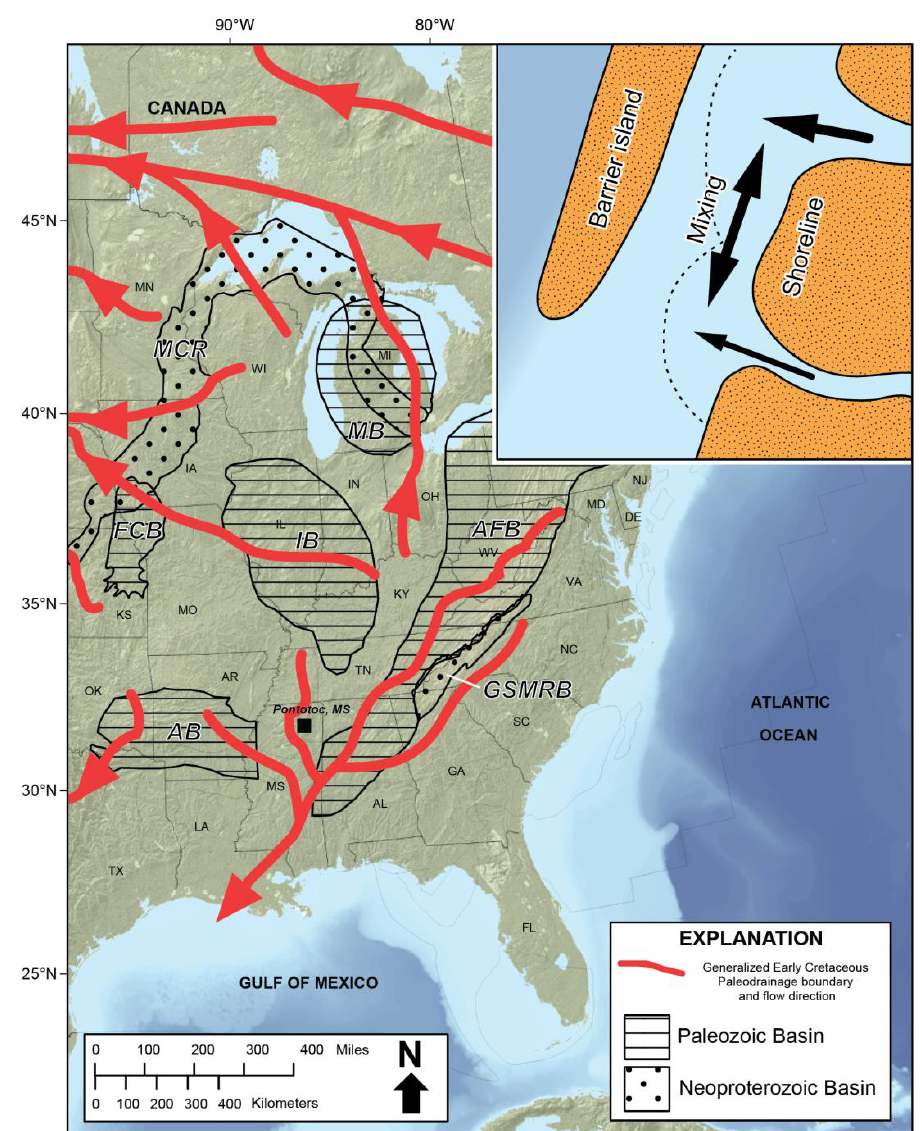
Figure 13. Map of the Paleozoic and Neoproterozoic basins of eastern North America. AB = Arkoma Basin, AFB = Appalachian Foreland Basin, FCB = Forest City Basin, GSMRB = Great Smokey Mountain Rift Basin, MB = Michigan Basin, MCR = Mid-Continent Rift. Modified from Coleman and Cahan [79]. Red lines indicate Late Cretaceous mid-continent paleodrainge and flow directions, modified from Blum and Pecha [1]. Inset: Generalized paleoenvironmental reconstruction of the region encompassing the northern and southern Pontotoc field sites (black square; see Figure 1B). Single-headed arrows represent fluvial input into back-barrier setting, thicknesses of the arrows represent relative volume of input based on salinity indicators from clay mineralogy. Dashed line represents approximate outline of subaqueous portion of deltas formed at river mouths. Double headed arrow represents mixing between the two fluvial sources.